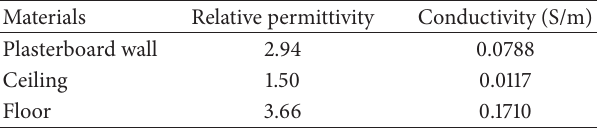
Table 1: Electromagnetic parameters of building